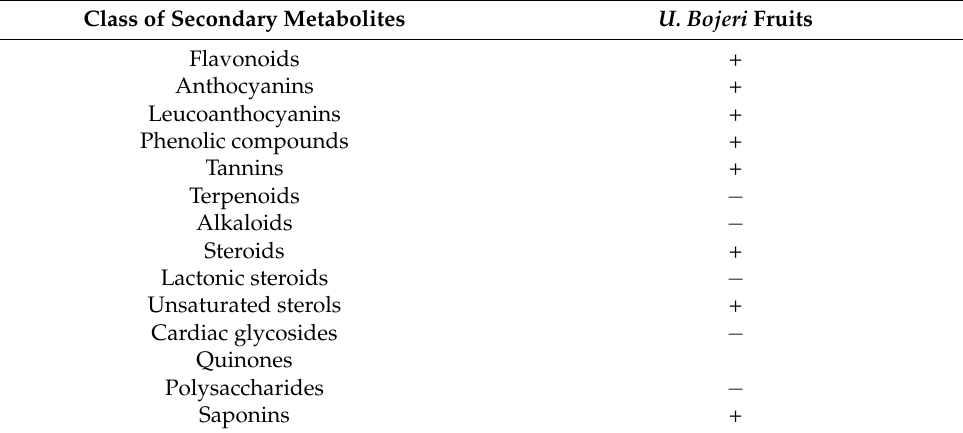
Table 1. Classes of secondary metabolites in the fruit of U. bojeri.